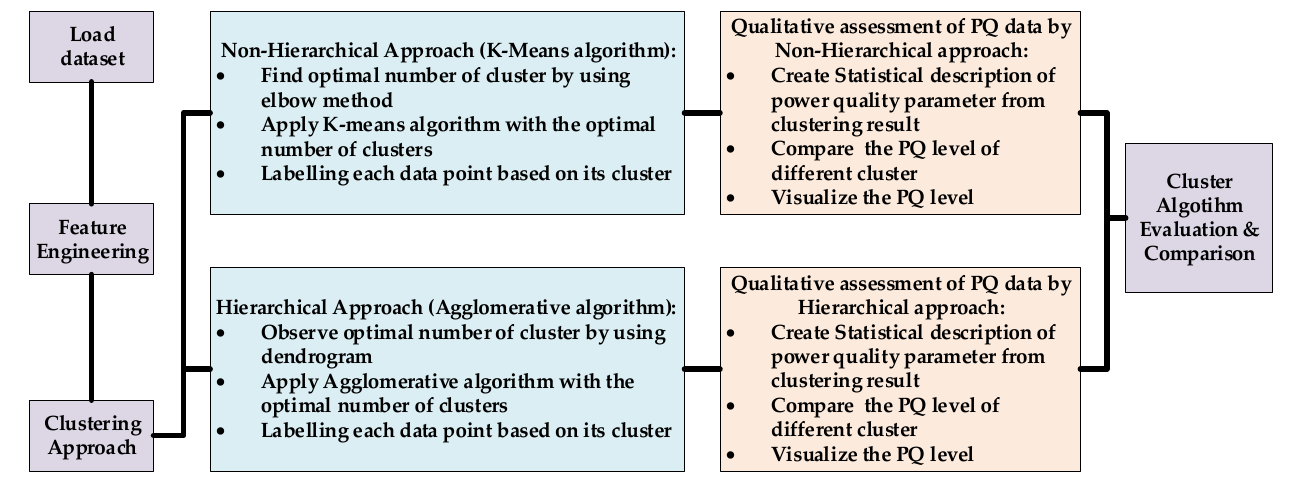
Figure 3. Proposed methodology schema.